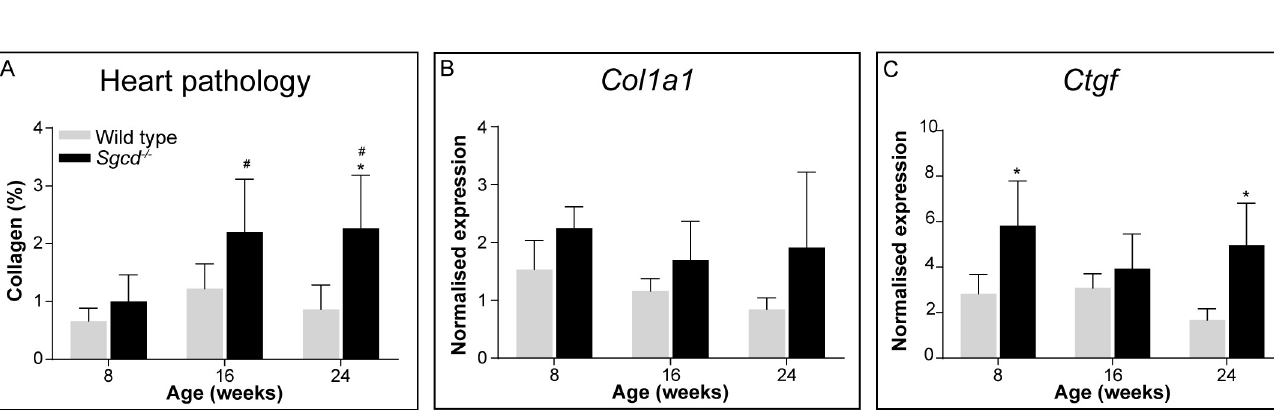
PLOS ONE | https://doi.org/10.1371/journal.pone.0220665 August 20,